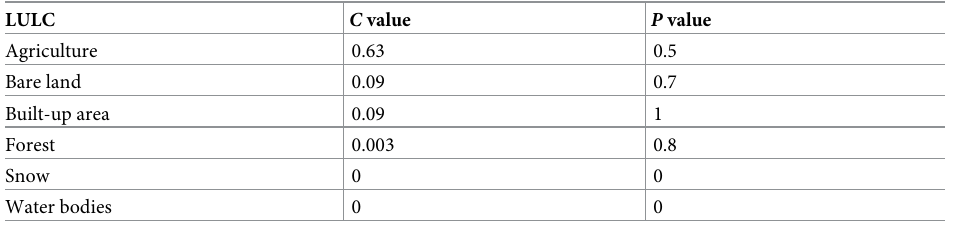
Table 3. C and P values for different